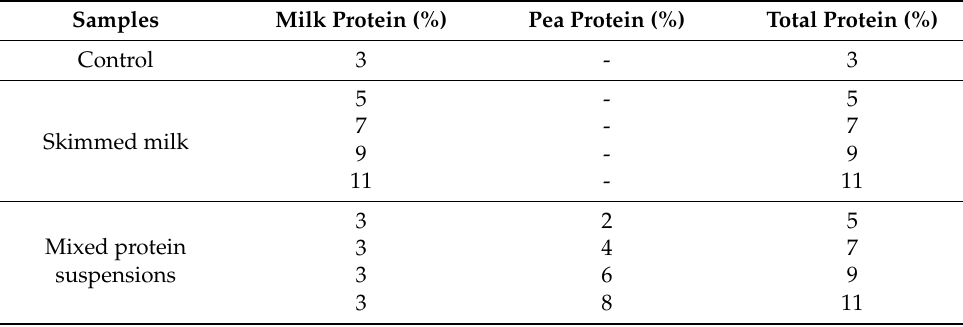
Table 1. Protein composition of the samples used in the present work.